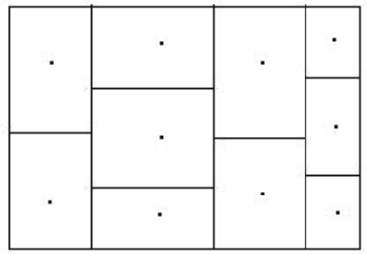
Figure 1. compound